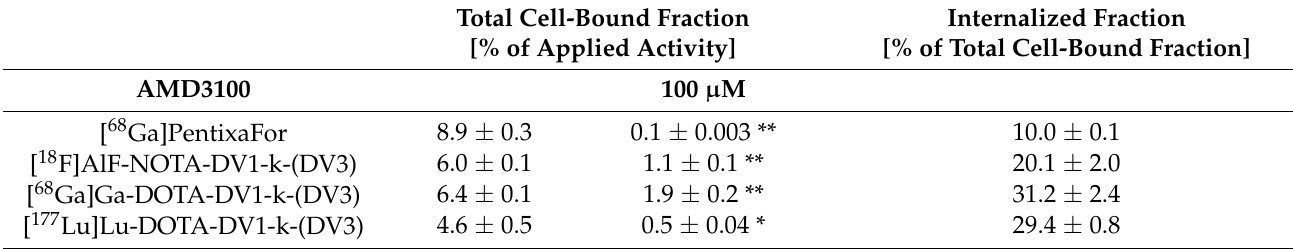
Table 3. Total cell-bound fraction (membrane-bound + internalized fraction) of the respective radioligands and the percentage of internalized radioligand were determined using hCXCR4-expressing U87 cells (2.5 × 10 5 cells/well, 60 min at 37 ◦ C) in absence or presence of AMD3100 (100 µ M). Statistical analysis independent-samples t -test. All data are expressed as mean ± SD ( n = 3). * p ≤ 0.01, ** p ≤